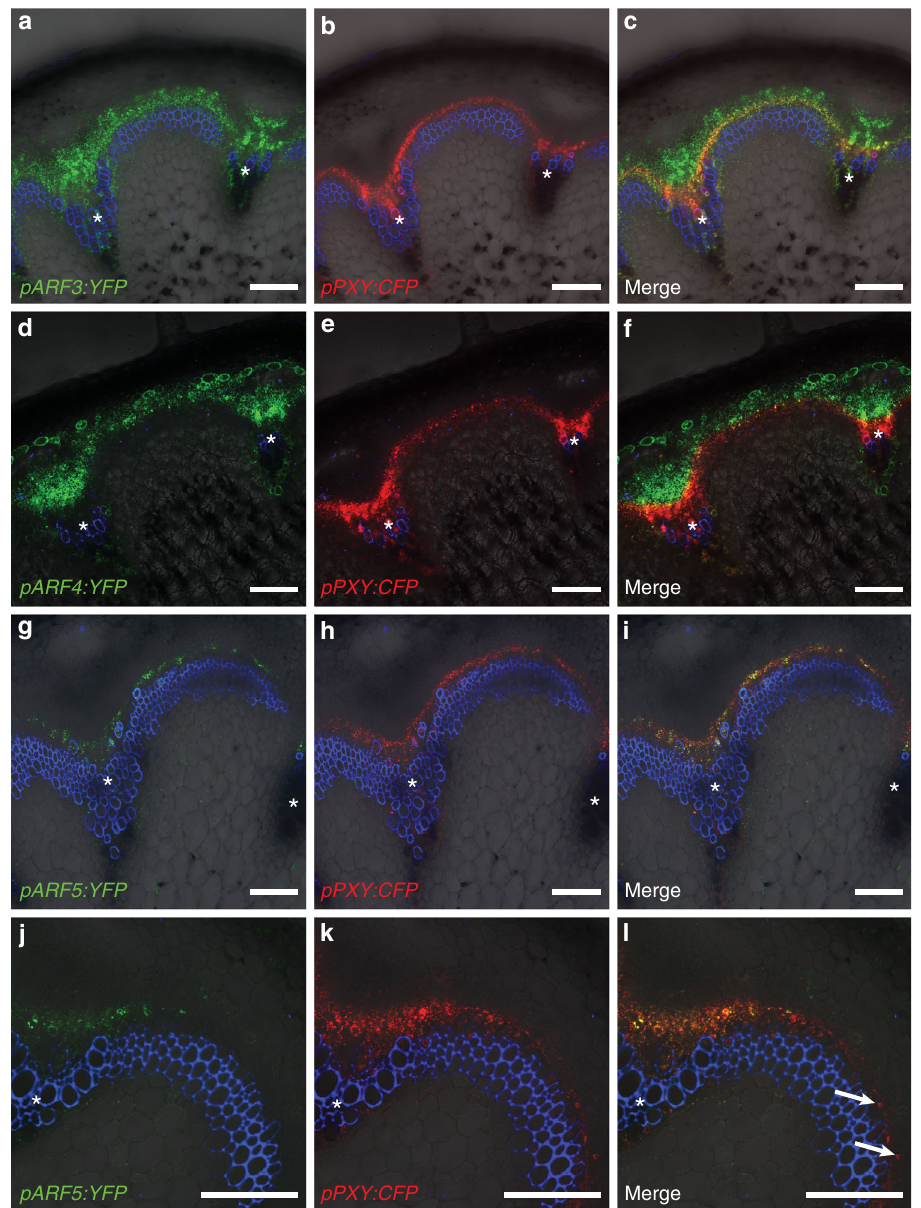
Fig. 2 ARF genes show distinct expression patterns in the cambium area. a – i Confocal analyses of stem bases of plants containing pARF3:YFP ( a – c ), pARF4: YFP ( d – f ) and pARF5:YFP ( g – i ), respectively, and the stem cell marker pPXY:CFP . Asterisks mark the vascular bundles. Size bars represent 100 µ m. j – l Confocal analyses of cross-sections from 5 mm above the stem base (transition zone) of plants containing pARF5:YFP and the stem cell marker pPXY:CFP . Arrows mark cells in the interfascicular region displaying CFP (red) but no YFP (green) activity. Size bars represent 100 µ m. PI staining in